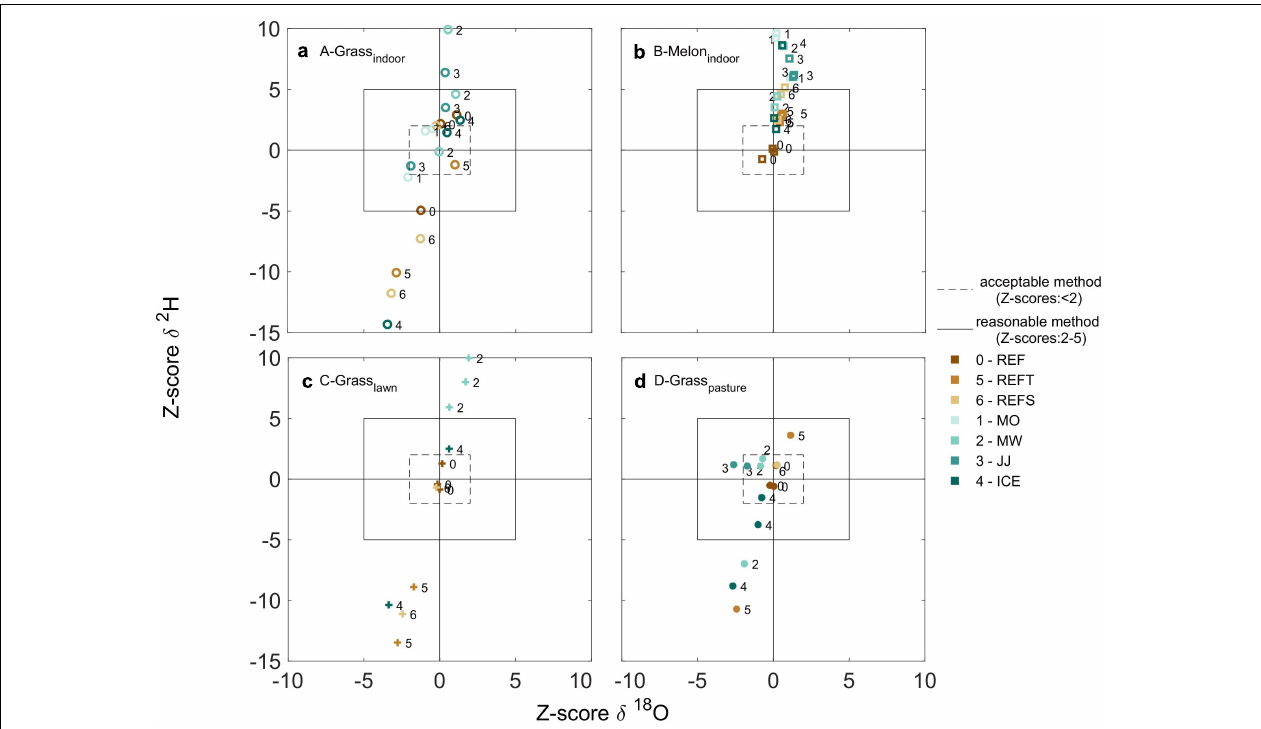
FIGURE 3 | For each plant group A-D (a–d) , performance of the different plant water extraction methods using the Z -scores. Symbols indicate the indoor grass (circles), melon (square), campus grass (cross), grass from the pasture (asterisk), and irrigation water (star). Different colors indicate cryogenic vacuum extraction (REF), simulated transport using REF (REFT), simulated storage using REF (REFS) and the different extraction methods MO, MW, JJ, and ICE (mojito, microwave, jam jar and ice cube, respectively).